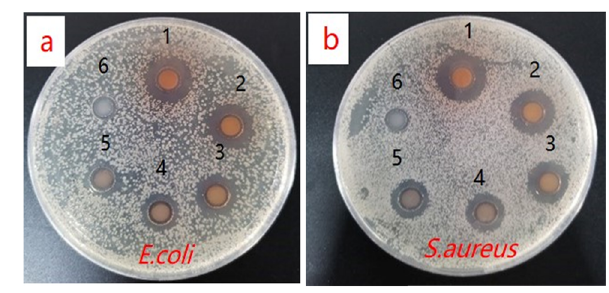
Figure 3: Photos of the inhibitory zones of the extracts. ( 1 ) 12 mg/mL, ( 2 ) 6 mg/mL, ( 3 ) 3 mg/mL, ( 4 ) 1.5 mg/mL, ( 5 ) 0.75 mg/mL, and ( 6 ) 0 mg/mL concentration extracts against ( a ) E. coli and ( b ) S. aureus